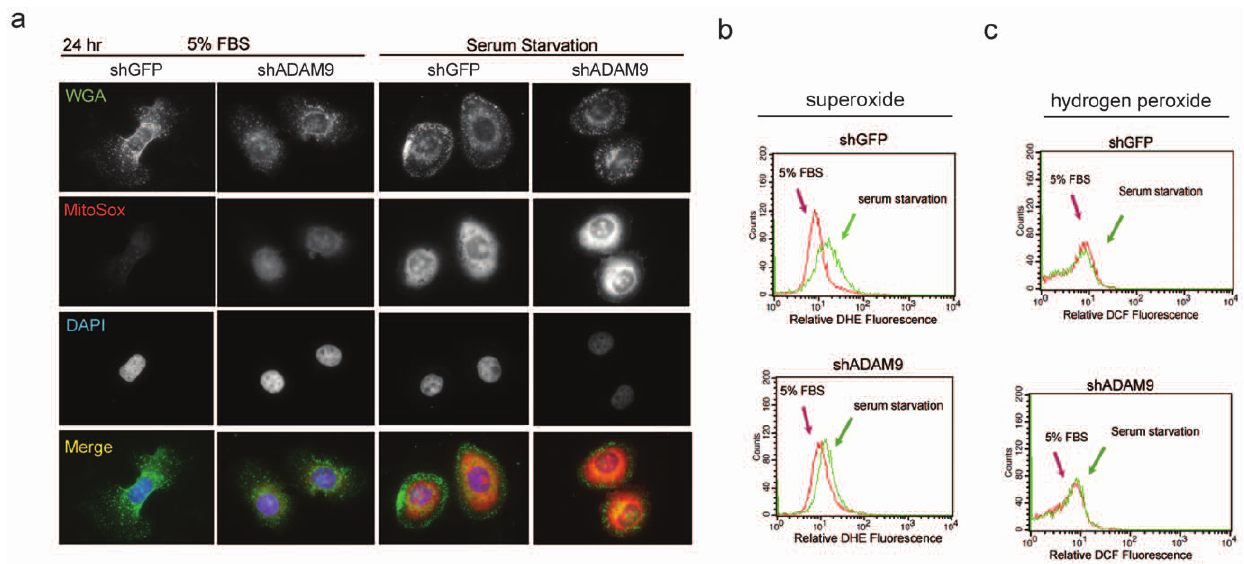
Figure 5. Knockdown ADAM9 expression enhances endogenous superoxide levels under stress condition. (a) PC3 shGFP and PC3 shADAM9 cells were cultured in either 5% FBS or under serum starvation for 24 hours, followed by treatment with 0.5 m M MitoSOX fluorescence. Equal intensity of fluorescence was used in each image capture for quantification of superoxide levels. (b) Elevation of endogenous superoxide concentrations level can be detected during serum starvation in both PC3 shGFP and PC3 shADAM9 . (c) Endogenous hydrogen peroxide levels did not differ between cells cultured in 5% FBS and under serum starvation.